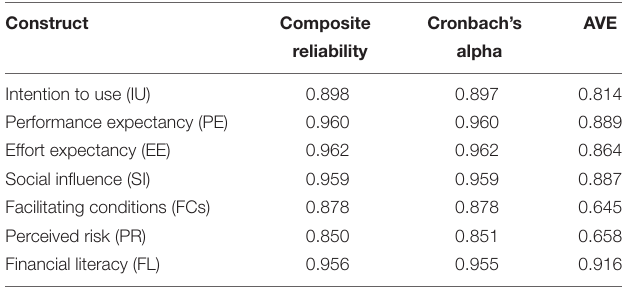
TABLE 3 | Construct reliability (composite reliability and Cronbach’s alpha) and convergent validity (AVE).